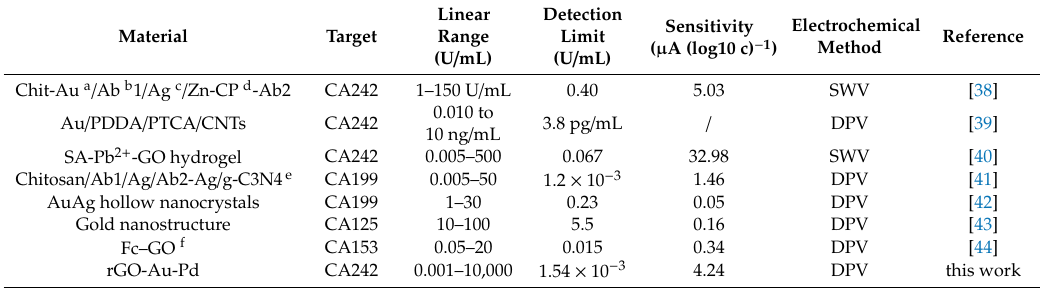
Figure 5. The immunosensor has a wide linear range for detection of CA242 in PBS. ( a ) Differential pulse voltammetry detection of varying concentrations of CA242 ranging from 0.001–10,000 U/mL. ( b ) Calibration curve showing the sensitivity of the immunosensor for the detection of CA242. Error bars represent the mean ± standard deviation ( n = 5). Table 1. Comparison of selected electrochemical sensors used in tumor marker detection.